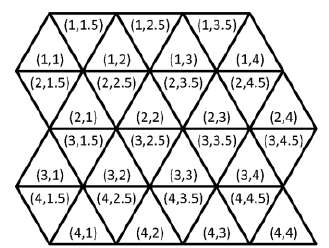
Figure 4. Triangular cells grid coordinates